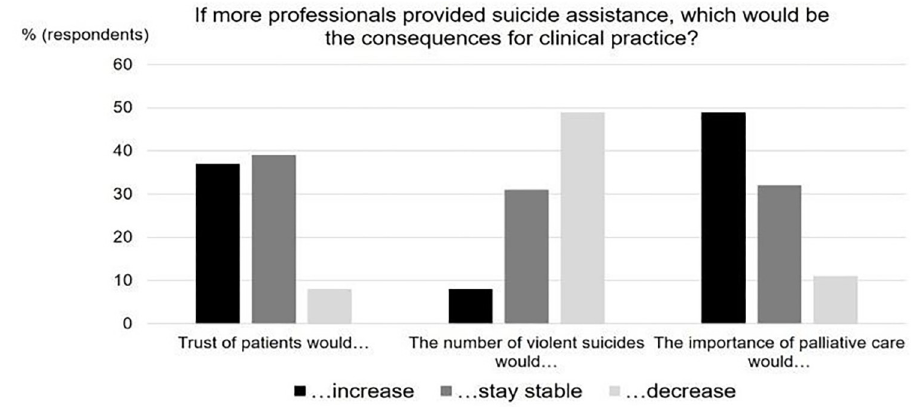
Fig 1. Expected consequences of more professionals providing suicide assistance. Participants did not think that patient trust would decrease. They mostly assumed that violent suicides would decrease and that the importance of palliative care would